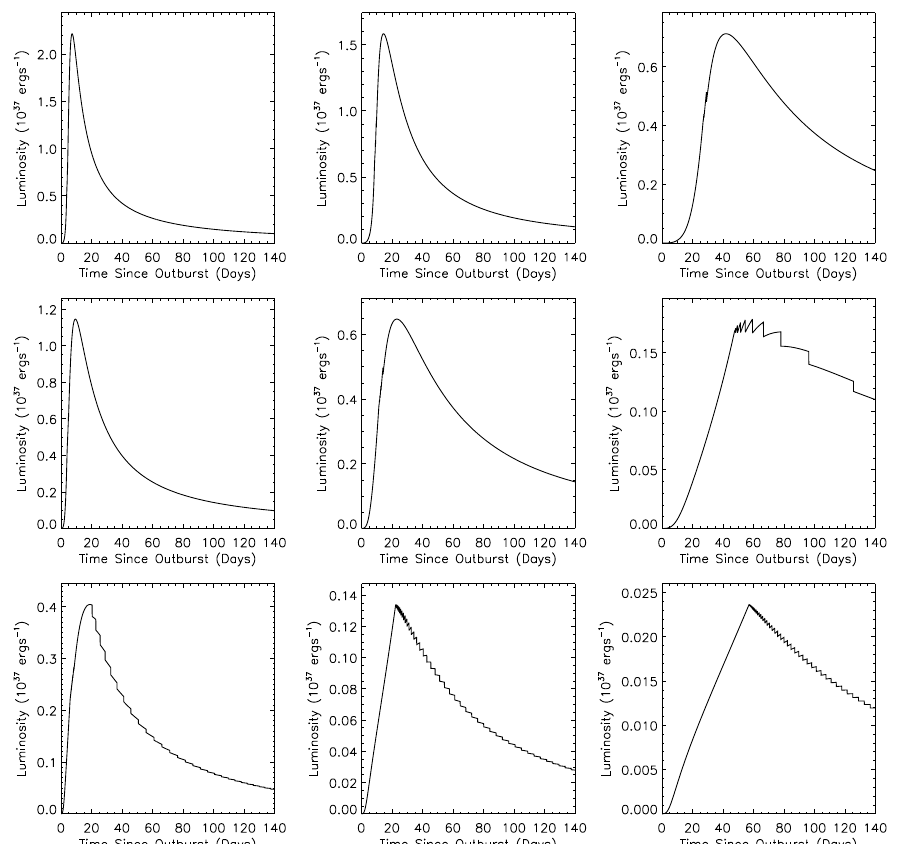
Fig. 4. Same as Figure 3, but with a Mira mass-loss rate of 10 − 6 M ⊙ yr − 1